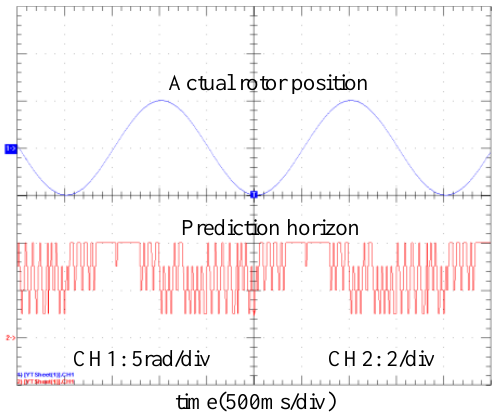
Figure 13. Rotor position and prediction horizon experimental results of the NMPSC with the proposed method.